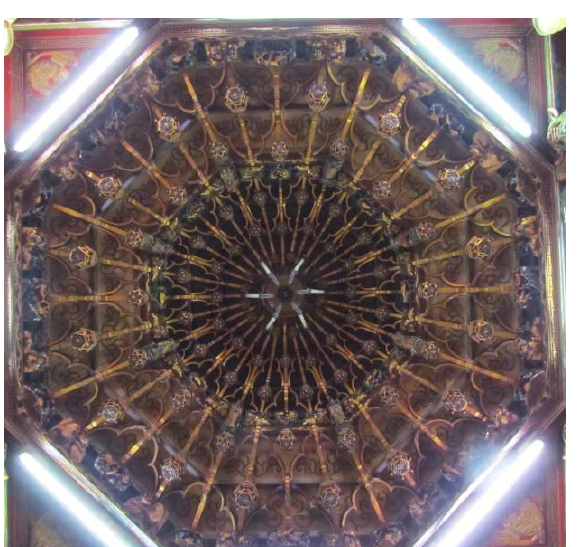
Figure 3. Lukang Tin Hau Temple and Caisson on the top ceiling